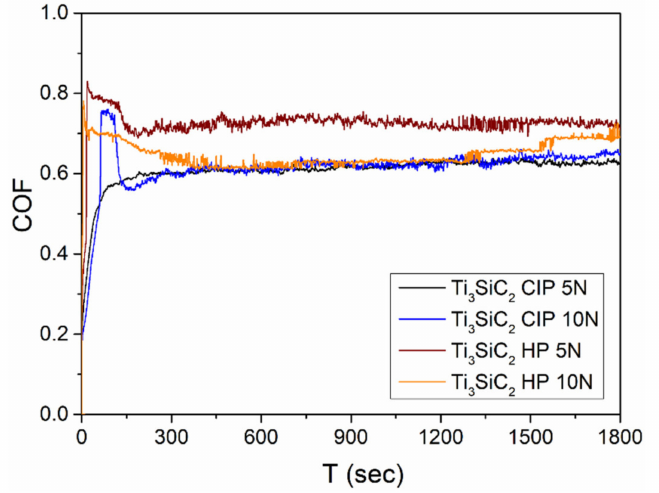
Figure 11. The coefficients of friction of the cold isostatic pressing and sintering (CIP) and hot-pressed (HP) samples during the reciprocating-sliding test with a load of 5 and 10 N of the Ti 3 SiC 2 MAX phase. On the other hand, hot-pressed Ti 3 SiC 2 samples tested at 5 N and 10 N have higher final coefficients of friction, with a stabilization value at around 0.72 for both loads. In this case, a slightly higher coefficient during the test for the lowest load (5N) can be